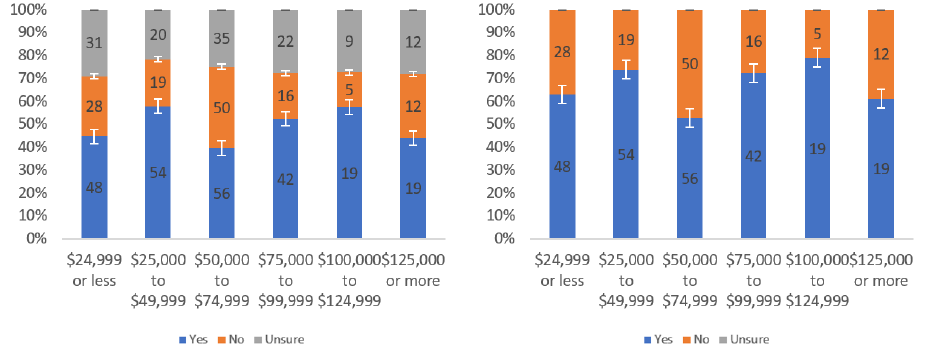
Figure A40. Responses regarding others’ willingness to review by income level including ( left ) and excluding ( right ) unsure responses.